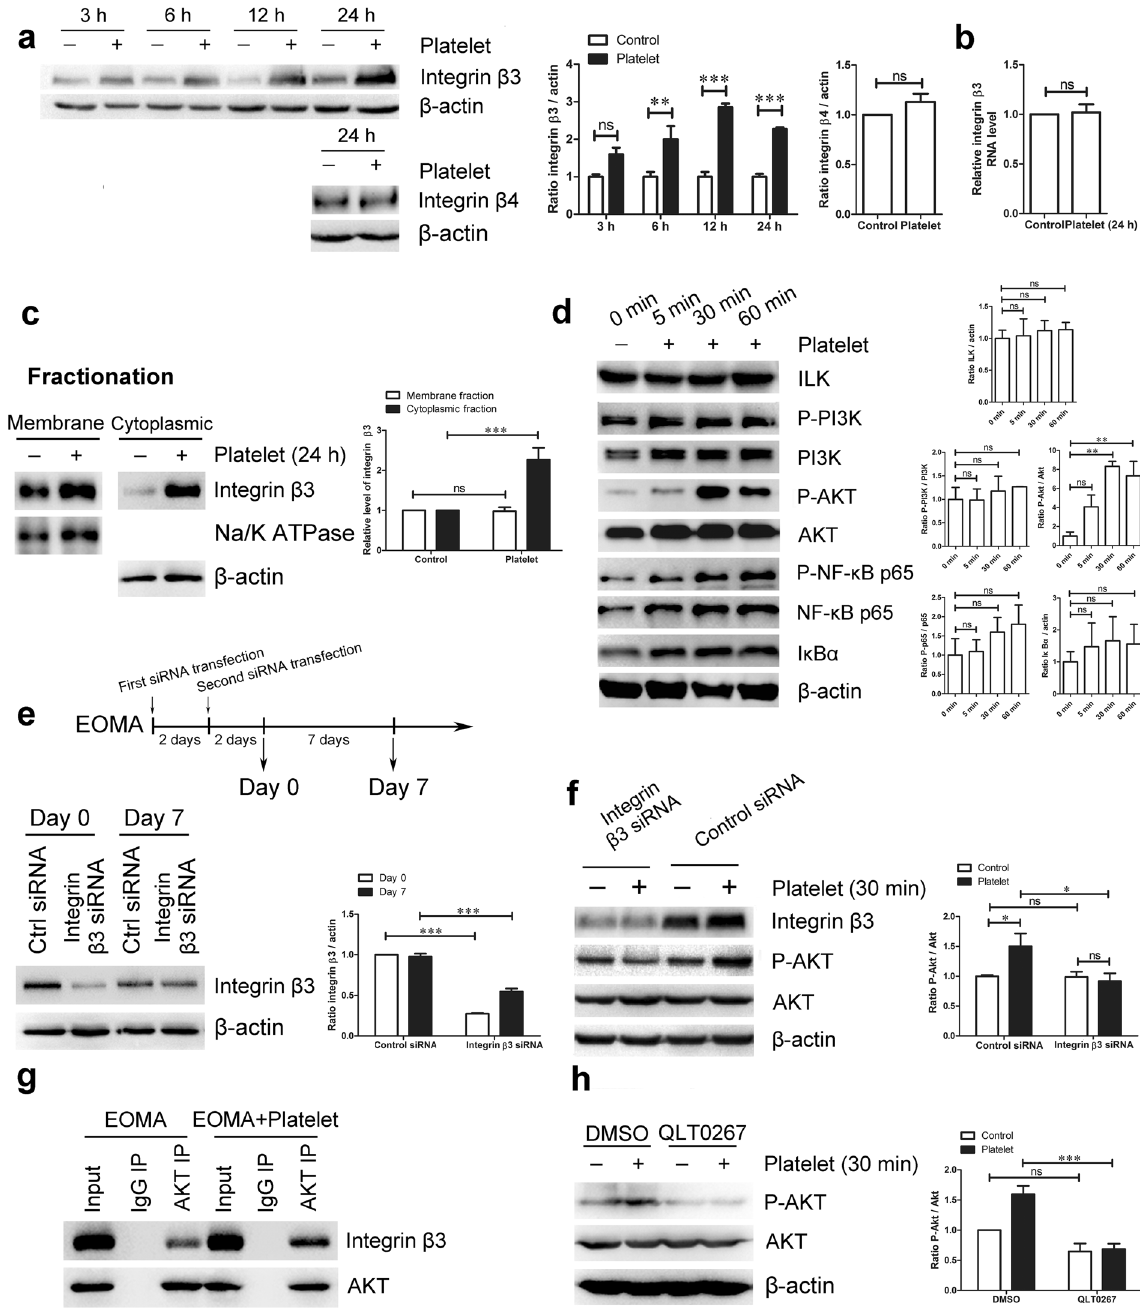
Figure 5. Integrin β 3 was associated to platelet-induced Akt phosphorylation in EOMA cells. EOMA cells were treated with platelets for indicated times and ( a ) the total protein levels of integrin β 3 and integrin β 4, ( b ) RNA level of integrin β 3, and ( c ) protein levels of integrin β 3 in membrane and cytoplasmic fractions were examined by either Western blot or real-time PCR. Na/K ATPase and β -actin were used as loading controls. ( d ) EOMA cells were treated with platelets for specified times and the levels of ILK, phospho-PI3K, PI3K, phospho-Akt, Akt, phospho-p65, p65, and I κ B α were assessed by Western blot. ( e ) EOMA cells were subject to siRNA transfections for 4 days and the level of integrin β 3 at indicated times was examined by Western blot. ( f ) EOMA cells were transfected with control or integrin β 3 siRNA for 4 days, and then treated with platelets for 30 minutes. The phosphorylation of Akt was assessed by Western blot. ( g ) EOMA cells were treated with or without platelets for 30 minutes then subject to immunoprecipitation using an Akt specific antibody. The interaction of integrin β 3 with Akt was then assessed via Western blot. ( h ) EOMA cells were pre-treated with 10 μ M QLT0267, and then incubated with platelets for 30 minutes. The phosphorylation of Akt was assessed by Western blot. n = 3–6, t-test, one-way or two-way ANOVA. * P < 0.05; ** P < 0.01; *** P < 0.001; ns, not